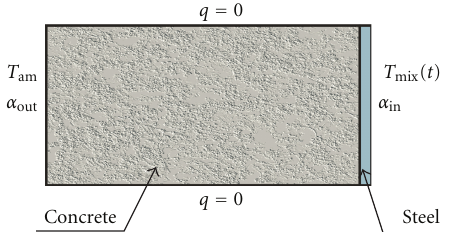
Figure 2: Sketch of a model heat transfer problem to estimate the parameters of heat exchange through the inner containment wall.